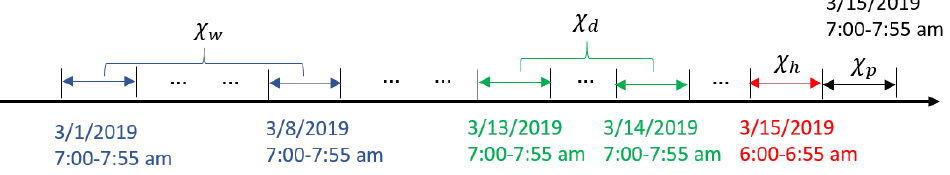
Figure 5. An example of extracting time series segments. X h , X d , and X w correspond to the three time series fragments input into the model. X p is the time series to be predicted and its length is T p . The lengths of X h , X d , and X w are T h , T d , and T w . Here, T p is equal to T h and T d , T w are double T h